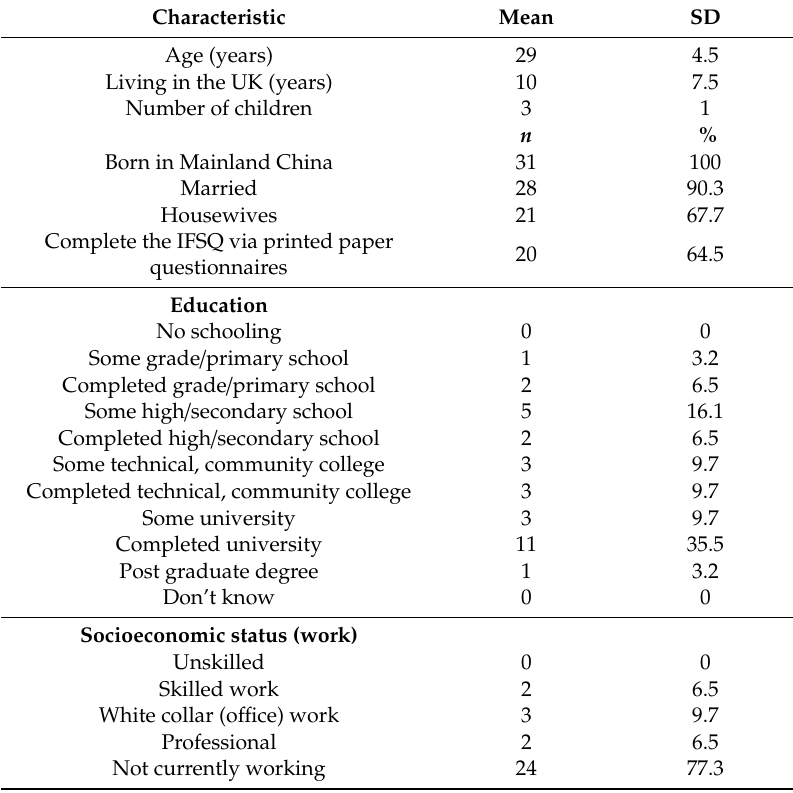
Table 2. Characteristics of the sample population ( n =